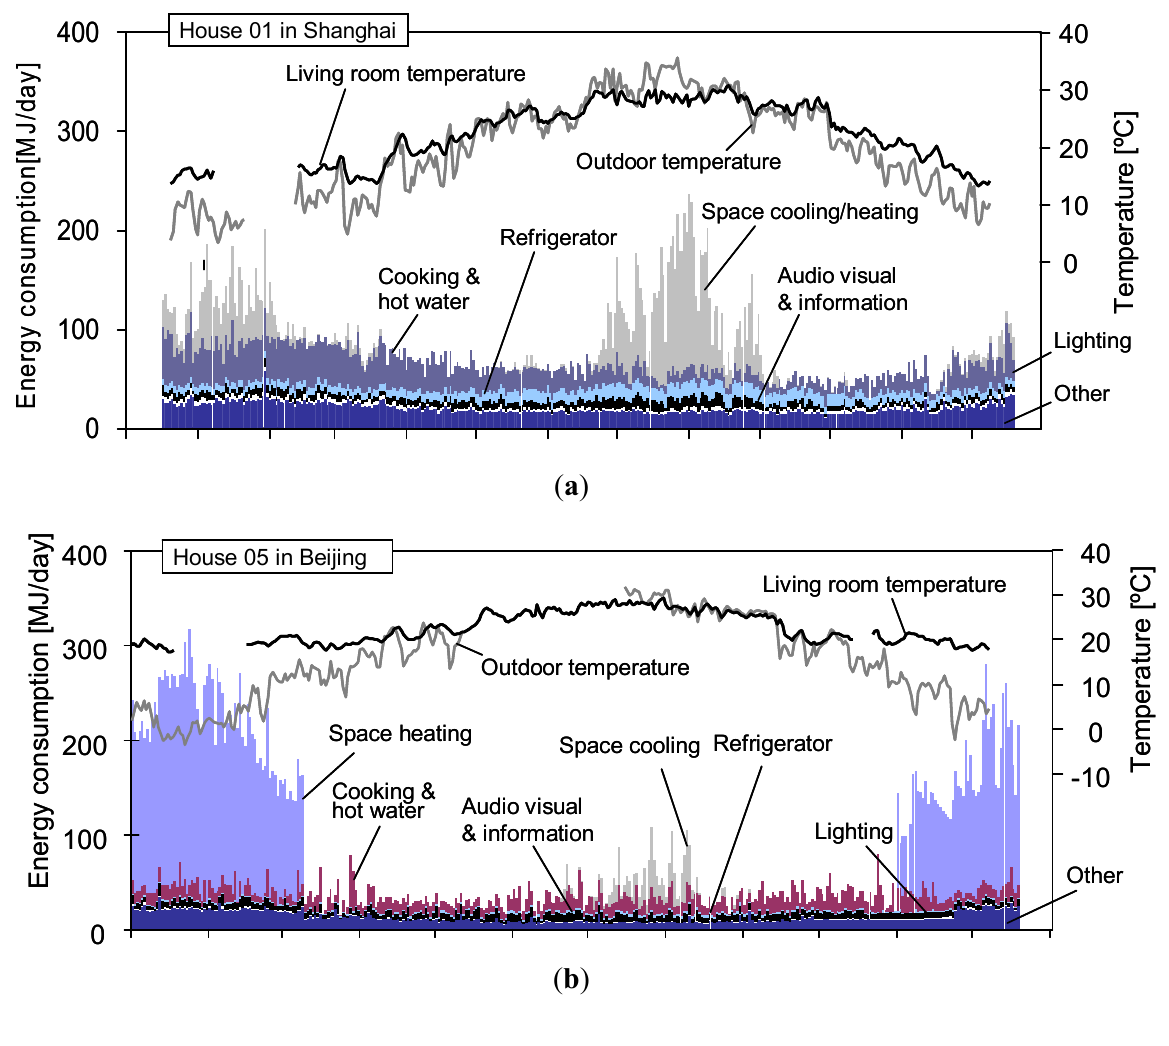
Figure 5. Daily year-round energy use and temperature of Houses 01 ( a ), 05 ( b ) and 08 ( c ). Note: (Bottom to top) Other, Lighting, Audio visual & information, Refrigerator, Hot water, Cooking, Space